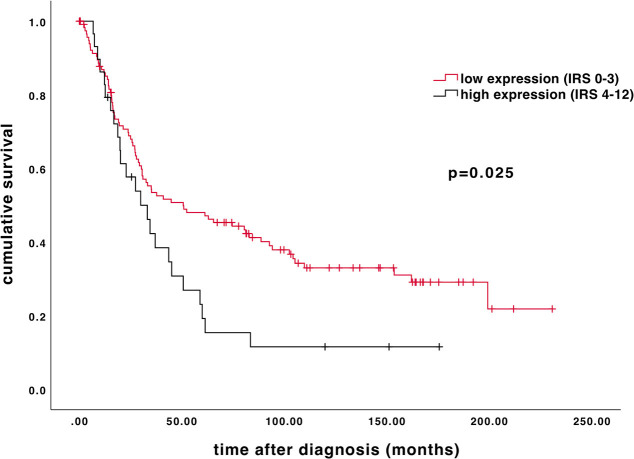
Kaplan–Meier estimate of β-arrestin 2. β-arrestin 2 expression (IRS 4–12) was associated with impaired overall survival (50.64 vs. 29.88 months, median; p = 0.025). Censoring events have been marked in the graphs.